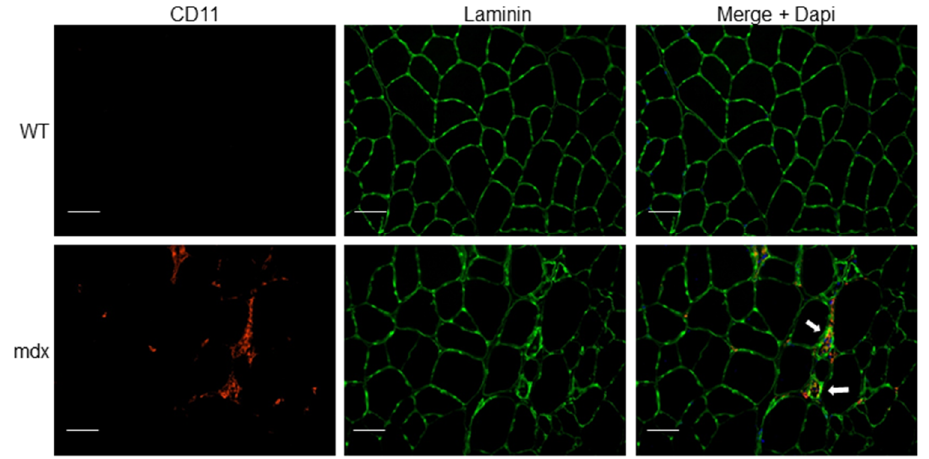
Figure 2. Immune cell infiltration in dystrophic muscle tissue. Tibialis anterior (TA) muscle cryosections from wild-type tions from wild-type (WT) and mdx mice were immunostained with anti-CD11b (myeloid cell (WT) and mdx mice were immunostained with anti-CD11b (myeloid cell marker) and anti-laminin (muscle fiber mem- marker) and anti-laminin (muscle fiber membrane stain) antibodies. Nuclei were counterstained with brane stain) antibodies. Nuclei were counterstained with 4′,6′-diamidino-2-phenylindole (DAPI, blue). Arrows indicate 4 (cid:48) ,6 (cid:48) -diamidino-2-phenylindole (DAPI, blue). Arrows indicate myeloid cell infiltrate (red) associated myeloid cell infiltrate (red) associated with focal invasion of muscle fibers (green). Scale bars, 50 μm. with focal invasion of muscle fibers (green). Scale bars, 50 µ